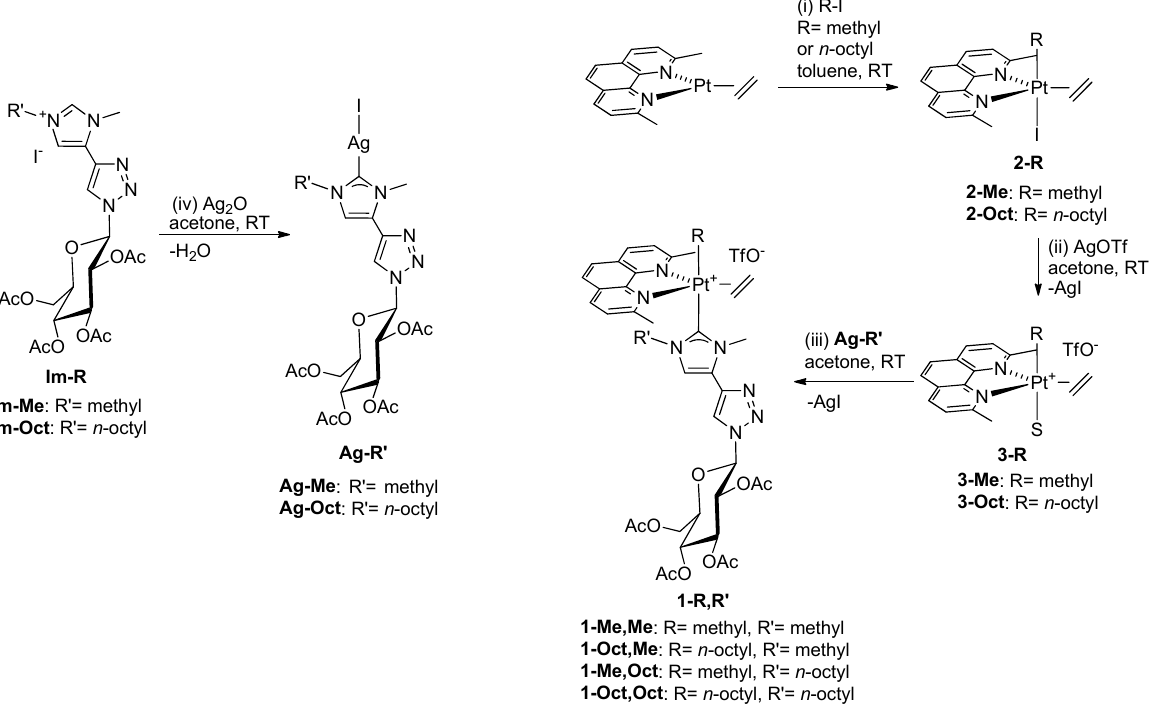
Scheme 2. Synthesis of the silver precursors ( Ag ‐ R’ ) and platinum 1 ‐ R,R’